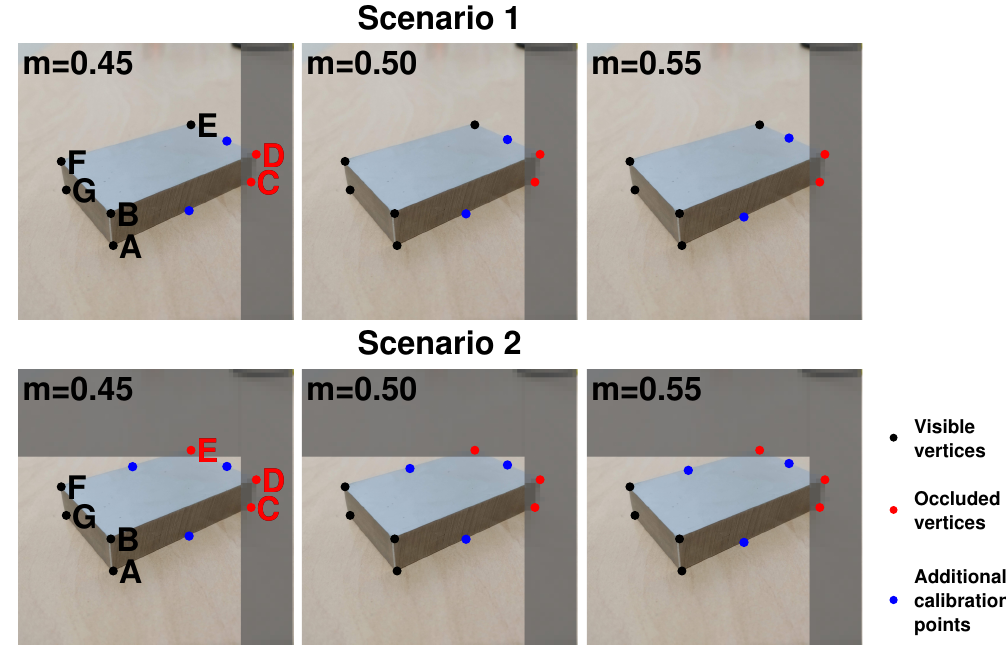
Figure 3. Scenarios with two and three occluded vertices: the black dots are the visible vertices, the red dots the occluded vertices (not used in calibration), and blue dots the additional points along the edges. The figures show the additional control points chosen along the edges with m = { 0.45,0.50,0.55 } . wDLT was tested with different values of uncertainty. For control points that were on vertices, = l = 1). Instead, for control points that the axis lengths of the confidence ellipses were the same ( l x y i i were not on vertices, but on edges, the axes of the confidence ellipses were set to be equal to one in = 1) and equal to 3, 15, and 10 6 in the direction parallel to the direction perpendicular to the edge ( l y i = { 3, 15, 10 6 } ). We chose these values in order to evaluate the sensitivity of wDLT with the edge ( l x i different ellipse eccentricities to the estimation of the uncertainty σ